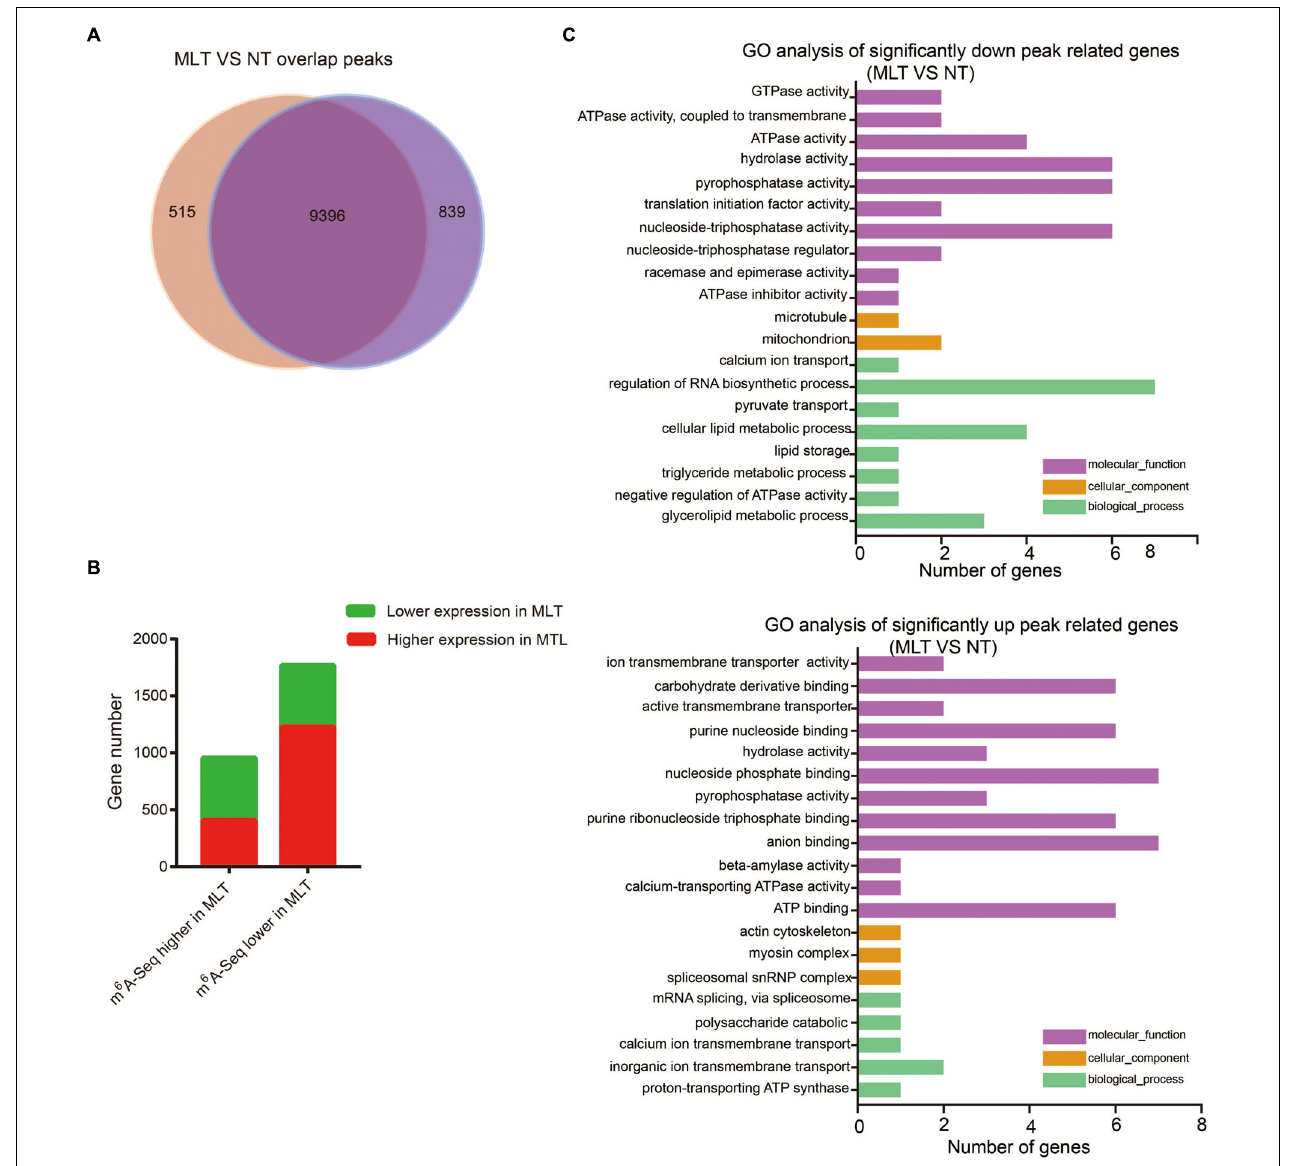
FIGURE 5 | Comparative analysis transcriptome-wide m 6 A profiles between NT and MLT anthers at stage-II. (A) The number of overlapped m 6 A peaks between NT and MLT anthers. (B) The gene number of transcripts with differential m 6 A enrichment and differential transcript levels between NT and MLT anthers. (C) GO analysis significantly different enrichment peaks related genes between NT and MLT